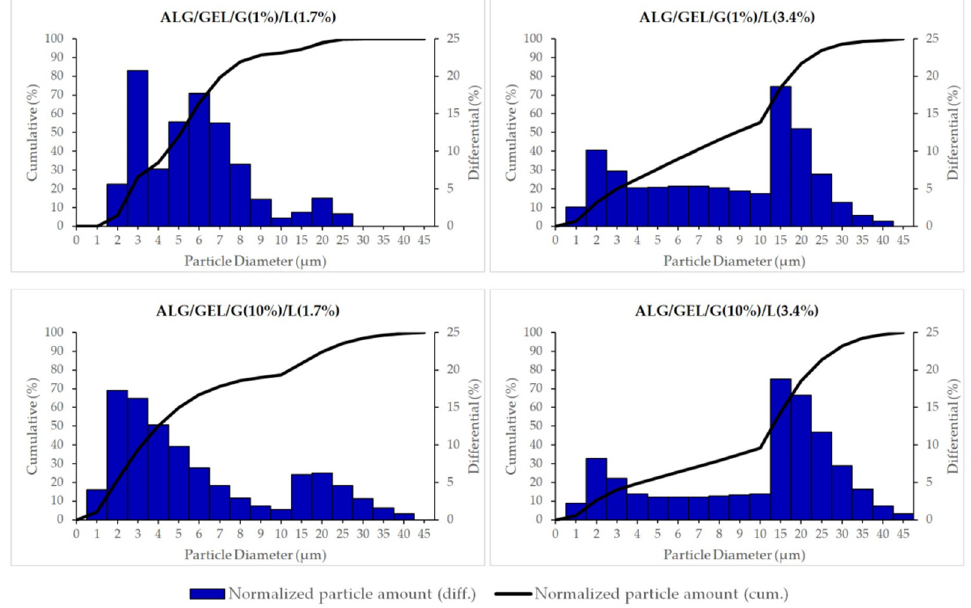
Figure 4. The size distribution of particles of prepared emulsion based on sodium alginate, gelatin, different amounts of glycerin, and lipids (cottonseed oil and beeswax).